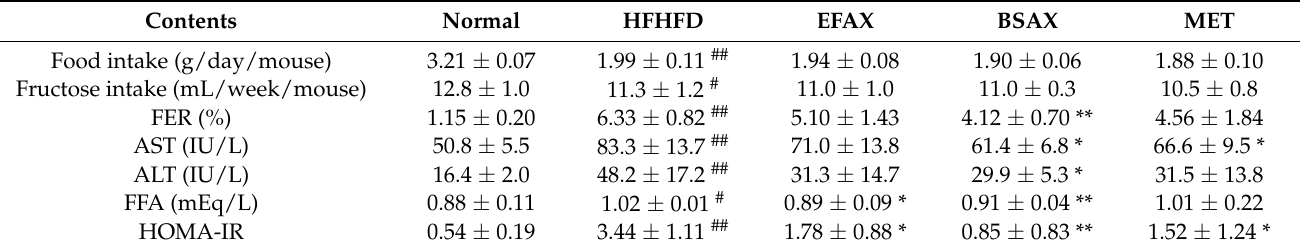
Table 1. Food and fructose consumption and biochemical parameters of